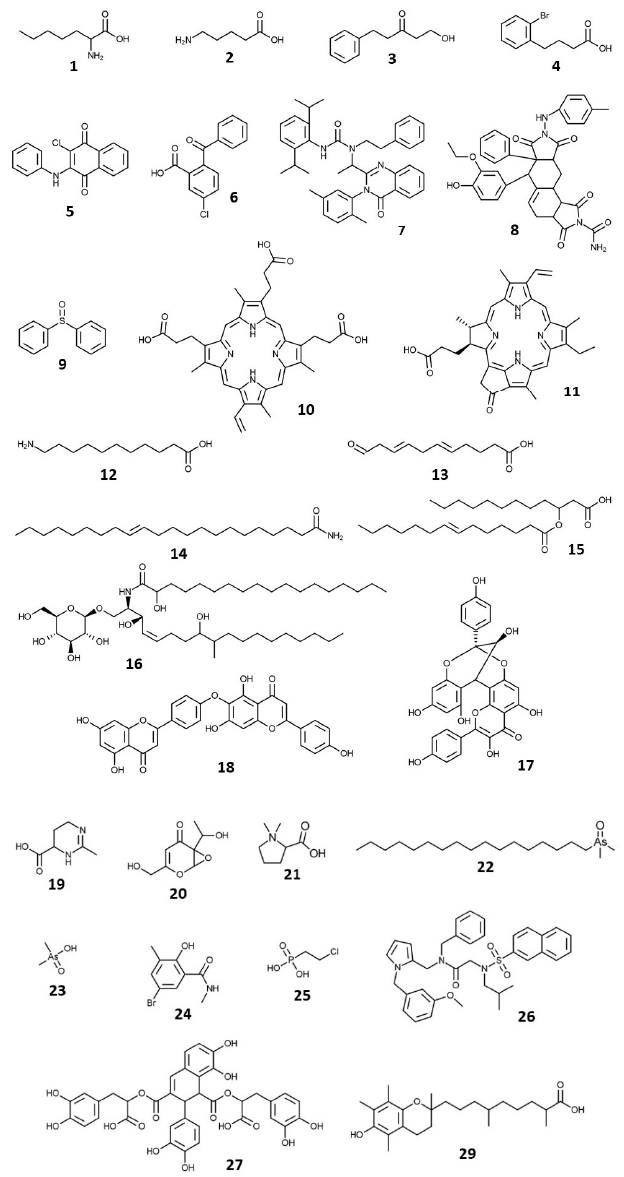
Figure 4. Chemical structures of the 28 secondary metabolites detected in the Sargassum polycystum extract (see Table 3 for names of the metabolites)